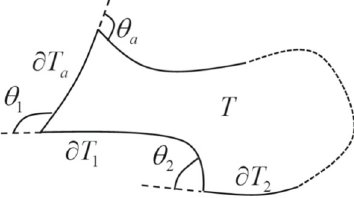
Fig. 1 Schematic figure for the Gauss–Bonnet theorem (adopted from Ref. [42])